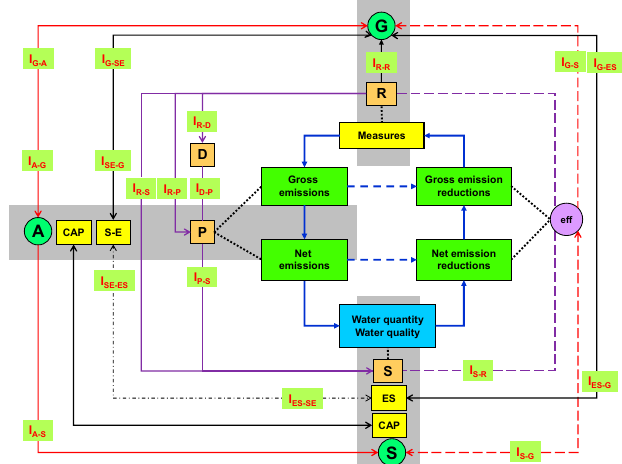
Figure 6. GASI, PTM, and DPSIR impacts (I) related to water mass and load balances. The central part shows the water balance with interactions between pressures (emissions), status (S) monitoring (of water quantity and quality), and calculated effects/efforts (eff) and responses (R, measures) based on emission reductions. Grey zones show corresponding factors of frameworks and balances. (CAP: Societal Capitals, eff: effects/efforts, ES: ecosystems, S-E: socio-economy). Arrows show impacts between factors.